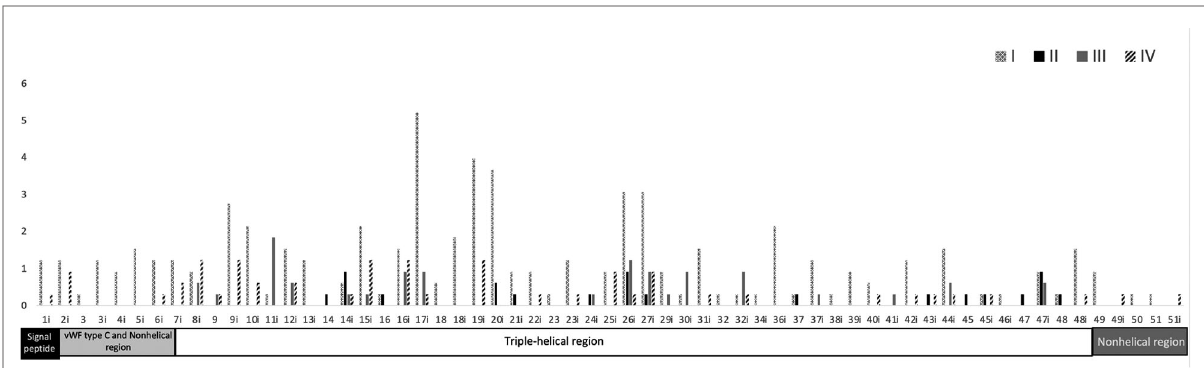
FIGURE 2 Frequency of the location of OI splice variants and COL1A1 domain distribution. Upper region: location of the type of OI splice variants along the COL1A1 introns and exons. OI is classi fi ed according to the Sillence classi fi cation in four types: I (mild) and IV (moderate deforming), frequent but less severe; II (lethal) and III (severe deforming), less frequent but more lethal. Most splice variants are located in intron 17. Black and white pattern=type I, black=type II, gray=type III, and oblique black=type IV. Lower region: functional domains along COL1A1 introns and exons. Most splice variants are located in the triple-helical region. Black square=signal peptide, light gray rectangle=von Willebrand factor type C and nonhelical region (N-terminal), white rectangle=triple-helical region, and dark gray rectangle=nonhelical region